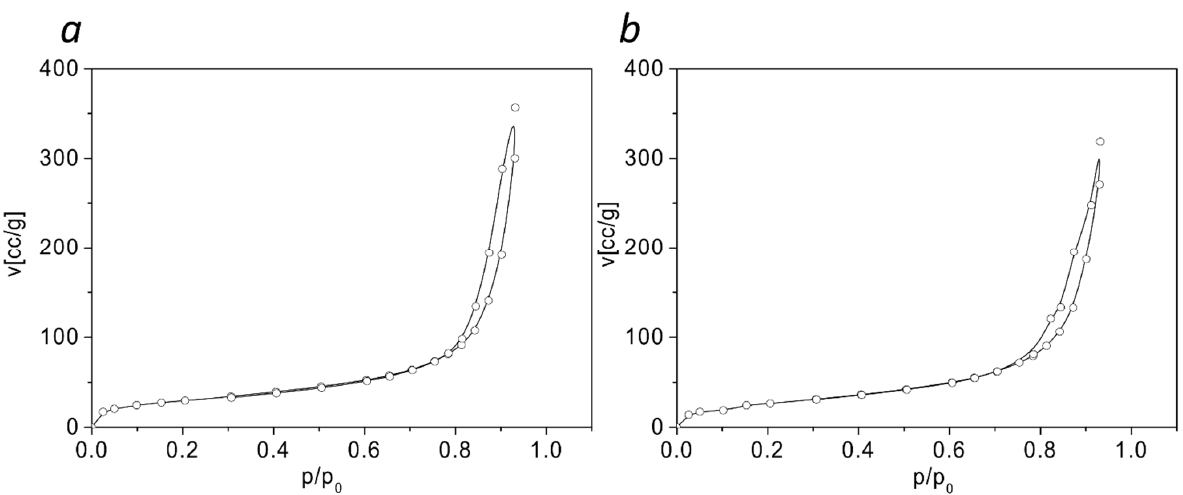
Figure 5. N 2 adsorption/desorption isotherms for composites ( a ) Silochrom/PLA and ( b ) Silochrom- NH 2 /PLA. Table 1. Structural characteristics of the composites.